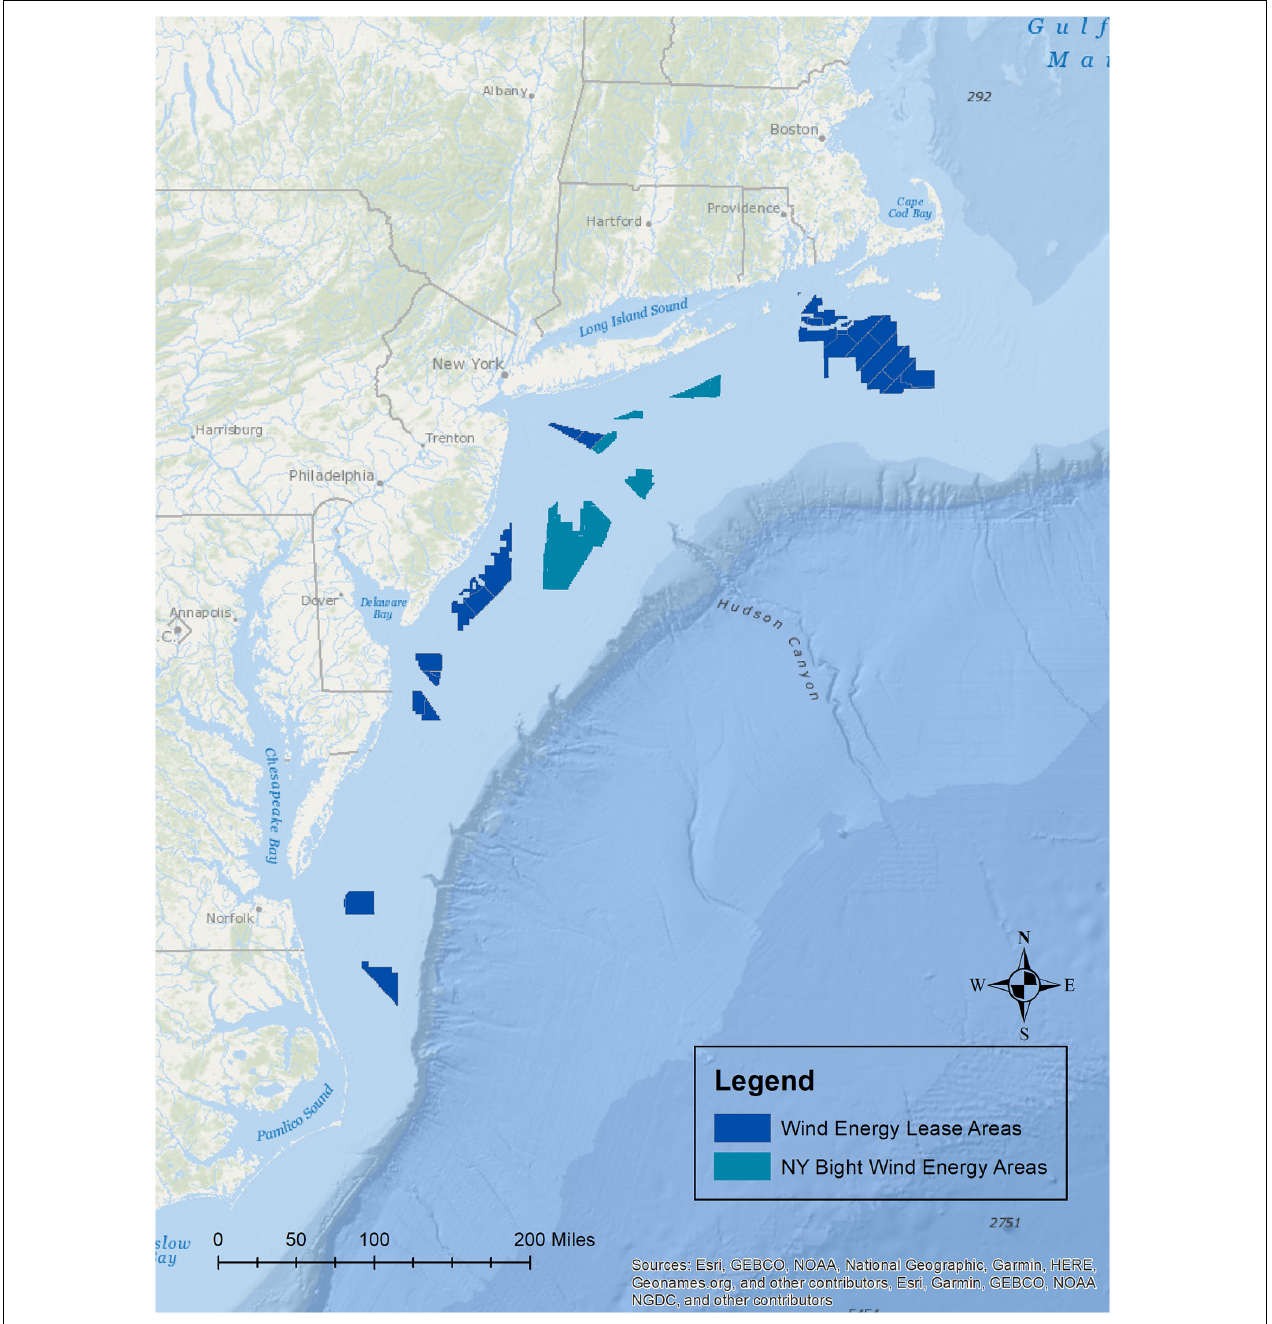
FIGURE 1 | Map of the current offshore wind lease areas off of the Atlantic coast of the United States, and the New York Bight wind energy areas to be